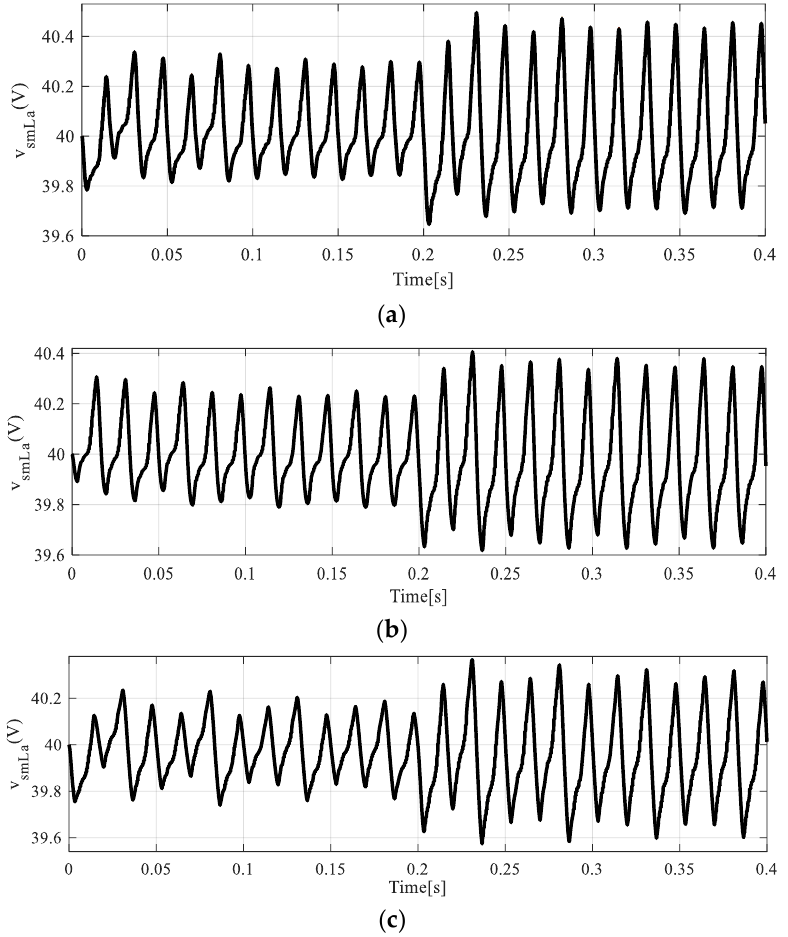
Figure 12. The lower SM capacitor voltages of phase “a” for the ( a ) first controller, ( b ) second controller, and ( c ) third controller.